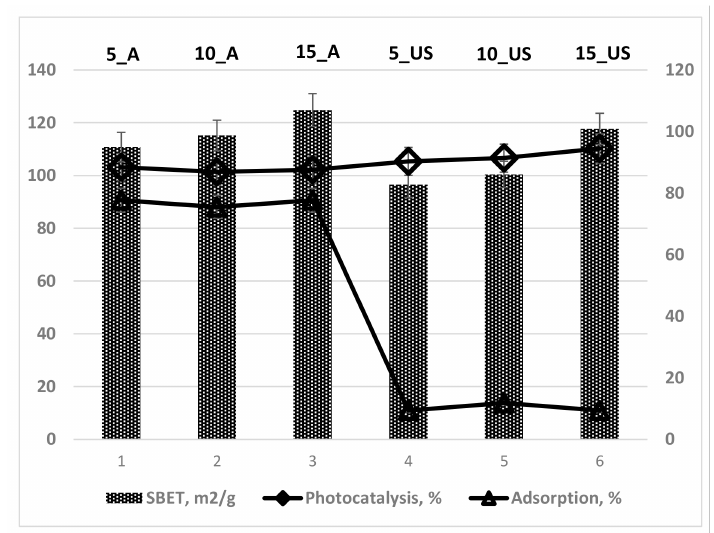
Figure 7. Correlation of photocatalytic activity and specific surface area for TiO 2 samples prepared.